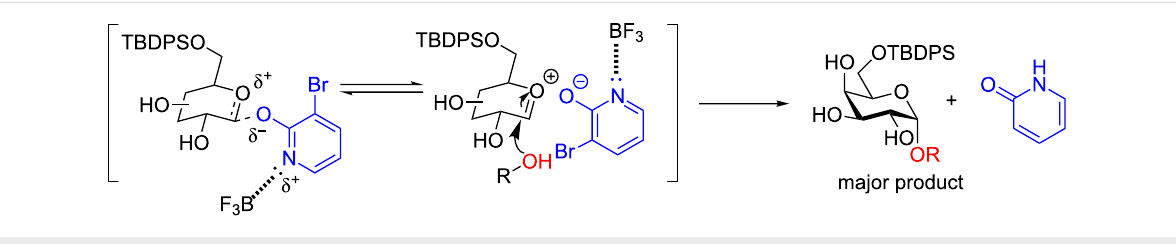
Scheme 9: Plausible mechanism for the synthesis of α -galactosides. TBDPS = tert